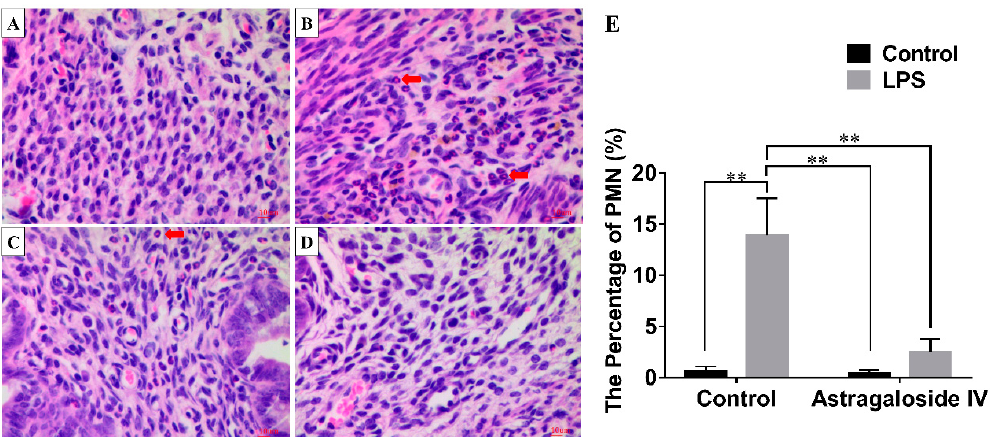
Figure 2. Effects of Astragaloside IV (AS IV) on lipopolysaccharide (LPS)-induced histopathological changes of uteri (hematoxylin-eosin staining (HE), ×400). Mice uteri from each group were processed for histological evaluation at 24 h after LPS infusion. ( a ): LPS − /AS IV − group. ( b ): LPS + /AS IV − . ( c ): LPS + /AS IV + group. ( d ): LPS − /AS IV + group. Red arrows represent polymorphonuclear neutrophils. ( e ): The percentage of polymorphonuclear neutrophils (PMN). Two-way analysis of variance was performed with a Bonferroni post hoc multiple comparison test. The data are shown as mean ± standard deviation (SD). n = 10. ** p < 0.01.